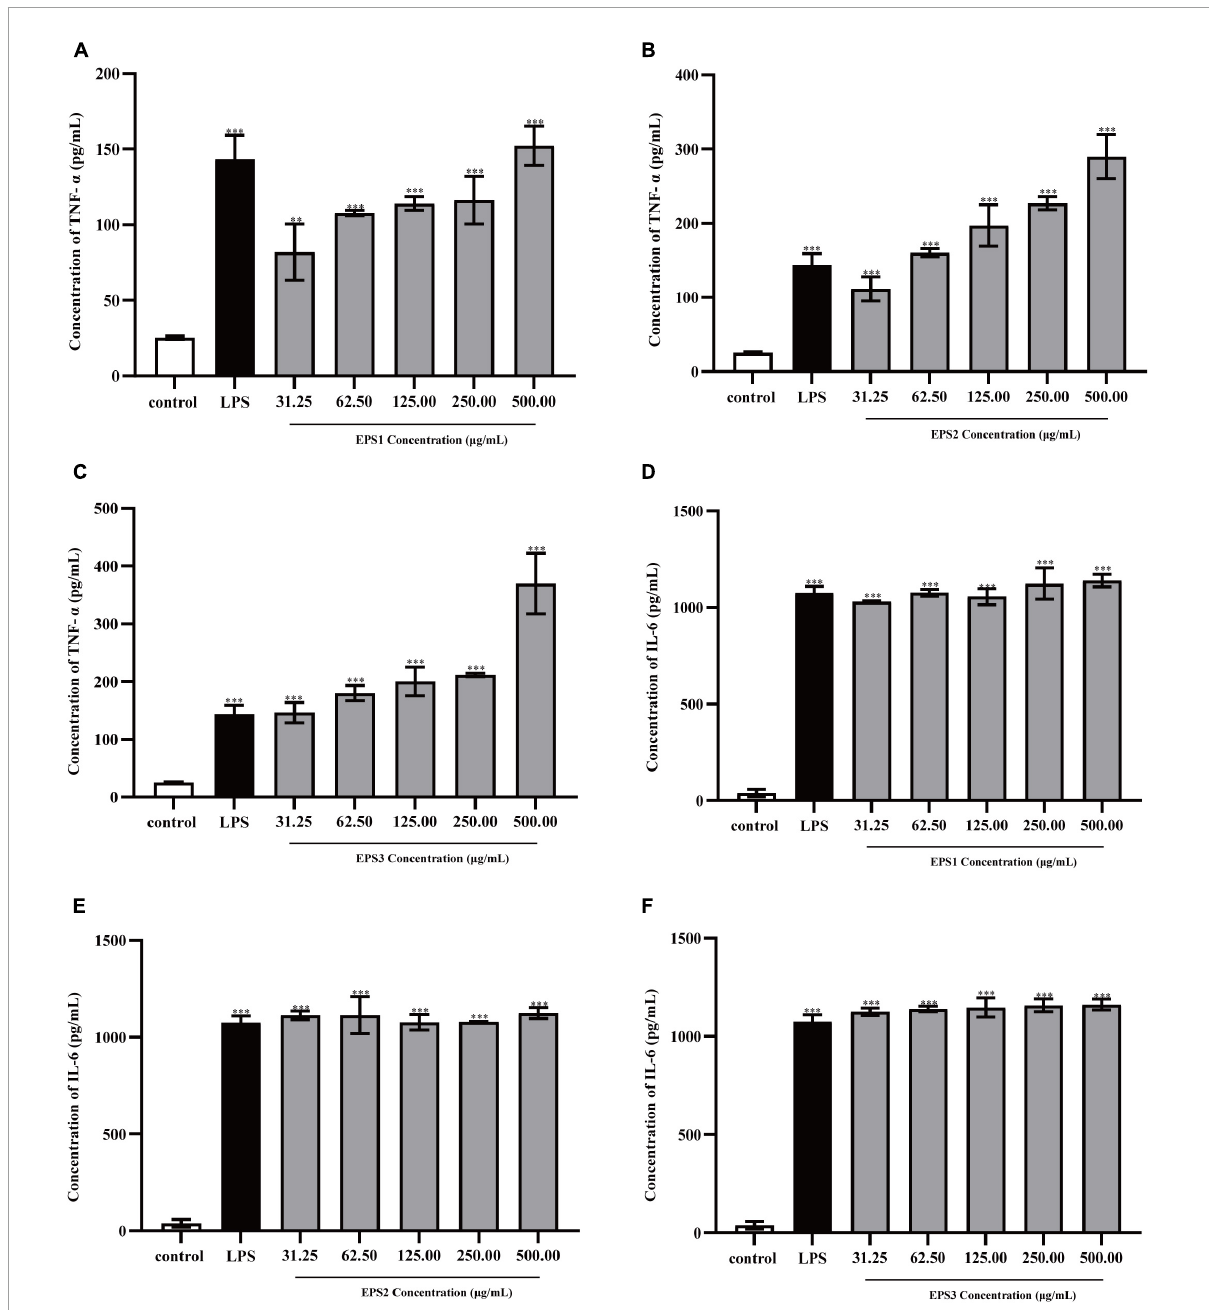
FIGURE10 Production of the cytokines TNF- α by peritoneal macrophage cells treated with purified (A) EPS1, (B) EPS2, and (C) EPS3. Production of cytokine IL-6 by peritoneal macrophage cells treated with (D) EPS1, (E) EPS2, and (F) EPS3. Data are expressed as the mean ± standard error of the mean ( n = 6). ∗∗ P < 0.01, ∗∗∗ P < 0.001, compared to untreated control. Error bars represent ±